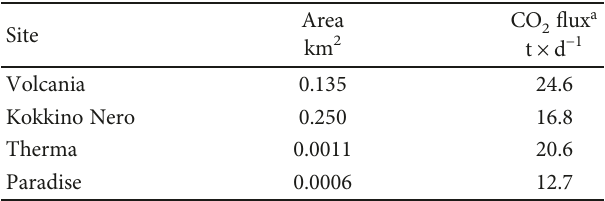
output estimations. 2